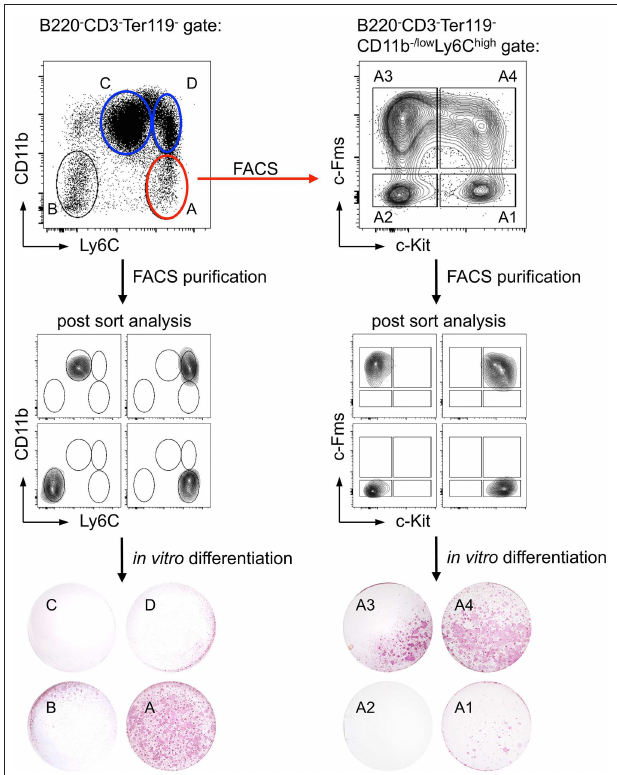
FIGURE 3 | Identification of a cell population with high in vitro osteoclast differentiation potential. Ly6C and CD11b expression of bead-enriched B220 − CD3 − Ter119 − BM cells was detected by flow cytometry. Four distinct populations (A: Ly6C high CD11b − / low ; B: Ly6C − CD11b − ; C: Ly6C low CD11b + ; D: Ly6C + CD11b + ) were FACS-purified and after post-sort analysis in vitro differentiated under osteoclast-forming conditions (cytokines: M-CSF and RANKL). The differentiated cultures were fixed and a TRAP staining was performed to identify mature osteoclasts. Additionally, population A was further subdivided by the expression of c-Kit and c-Fms